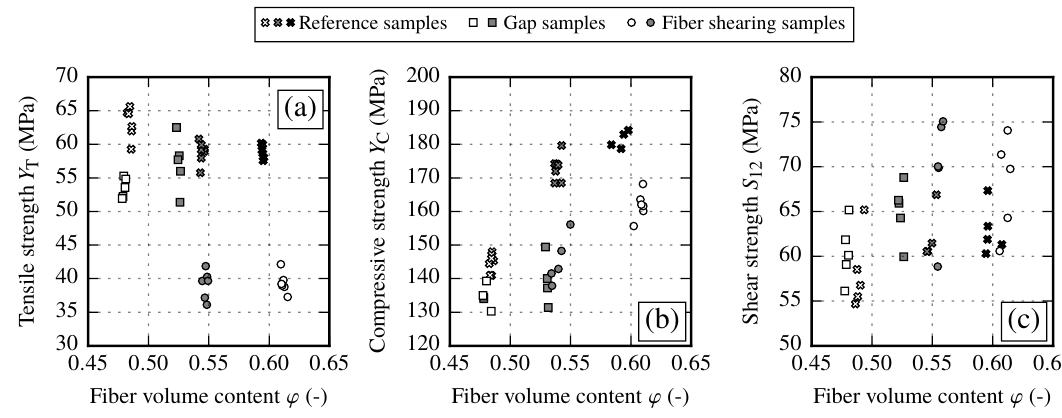
Figure 20. Comparison of the transverse strengths ( Y T ( a ) and Y C ( b )) and the in-plane shear strength S 12 ( c ) for different draping effect